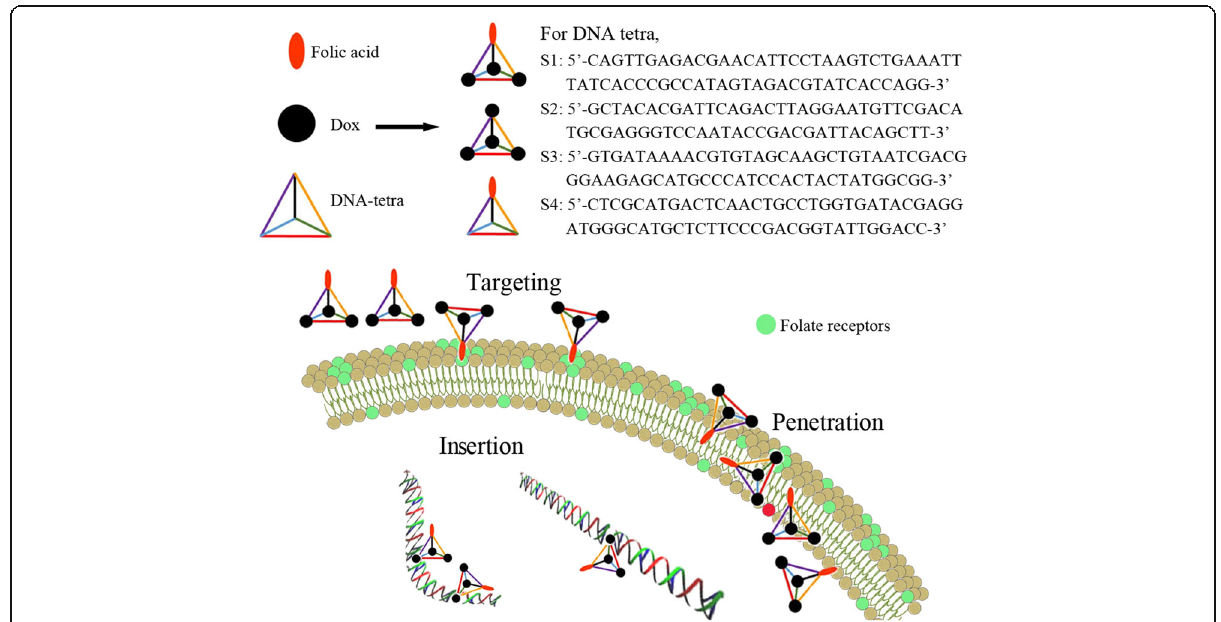
Fig. 1 Schematic diagram of folic acid-DNA tetra-Dox, DNA tetra-Dox, and folic acid-DNA tetra. The single-strand DNA sequences of DNA tetrahedron were provided. The process of targeting for tumor cells, penetrating through the cellular membrane, and inserting the DNAs were